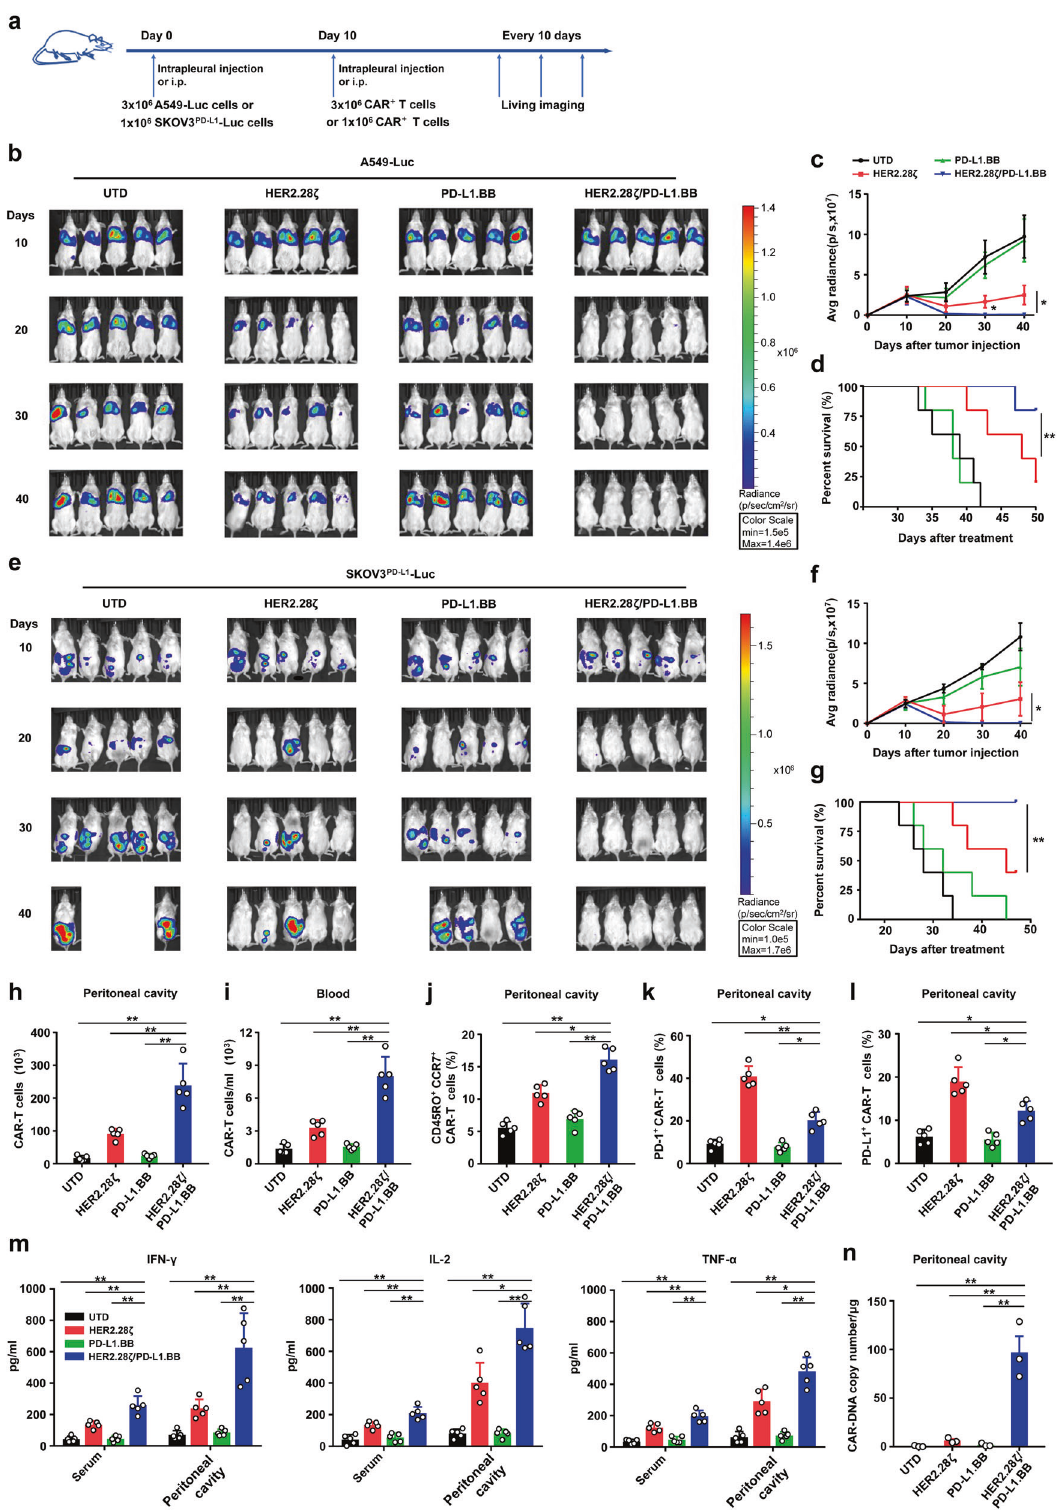
(Fig. 6c). Furthermore, the protein-protein interaction (PPI) net- work analysis showed that the main DEGs identi fi ed had close interactions, and the top 6 molecules were IL-10, IL-4, IL-2, IL-17A, IFN- γ and TNF- α . Among which, the expressions of anti-tumor cytokines including IL-2, IL-15 IL-17A, IFN- γ and TNF- α were